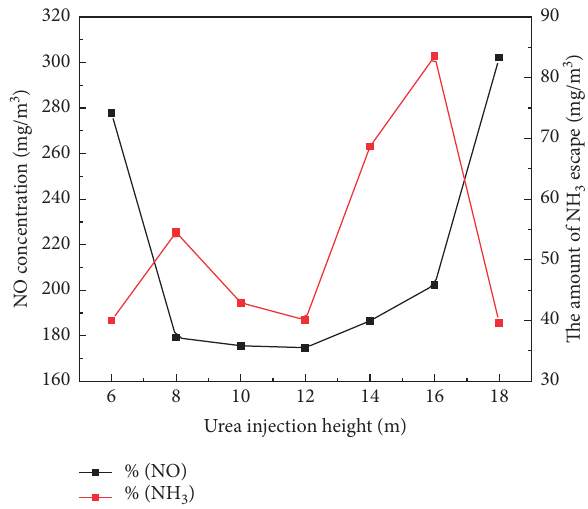
Figure 6: NO concentration and NH injection